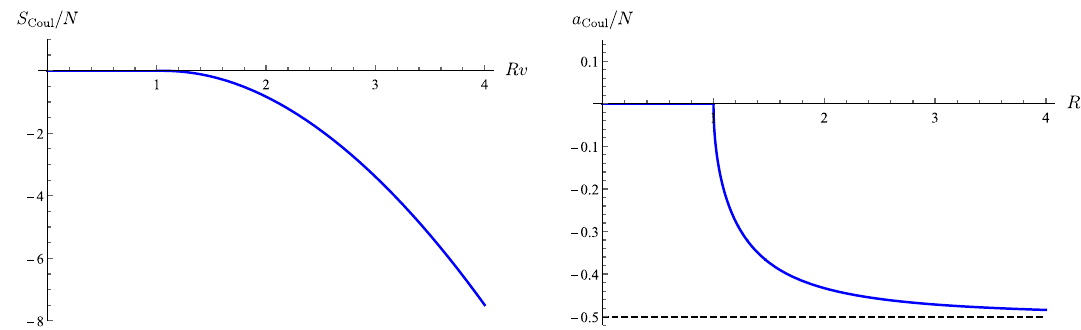
Figure 2 . Left: contribution of the Coulomb branch D3-brane to EE, S Coul in eq. (4.29), divided by N , as a function of Rv . Right: the quantity a Coul ( R ) defined in eq. (4.34) as a function of Rv . The function is continuous but not analytic at Rv = 1